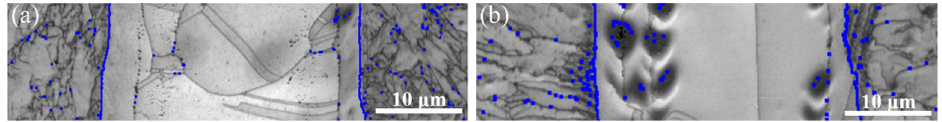
Figure 5. Corresponding band contrast (BC) maps from an area of joint region: ( a ) prior to tempering treatment and ( b ) subject to tempering treatment.